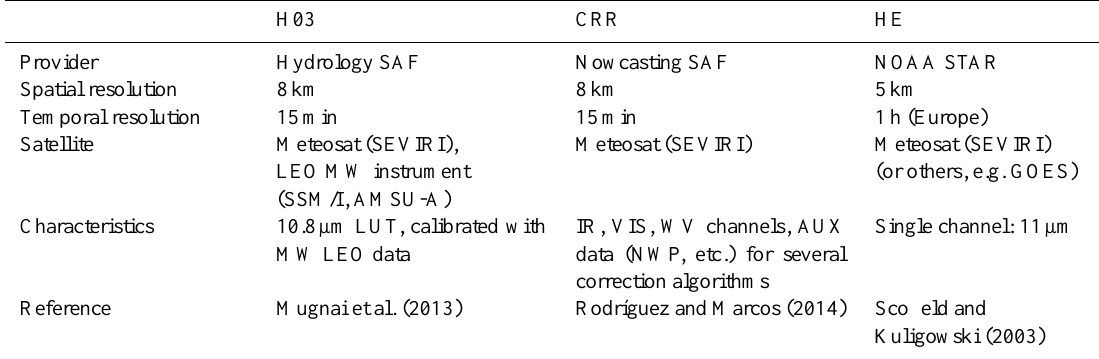
Table 1. Overview of satellite products evaluated.